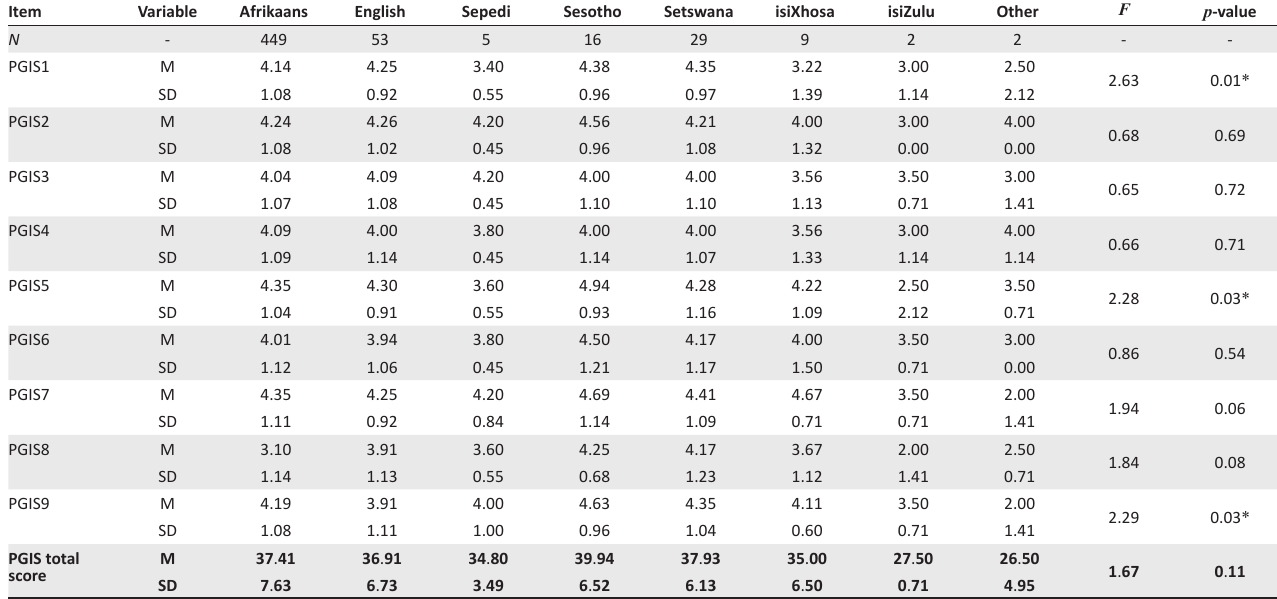
TABLE 5: One-way between groups ANOVA results for the PGIS items and the different languages for the I-O Psychology students ( N = 565). Item Variable